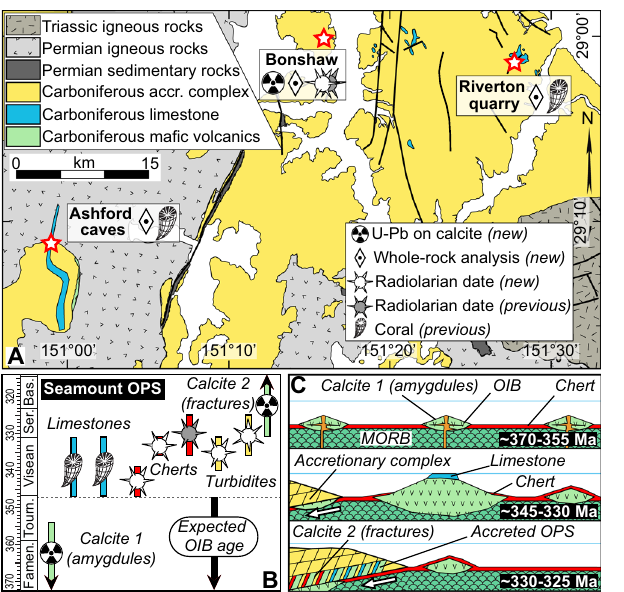
Fig. 2 Location, age, and tectonic interpretation of the sampled sections.